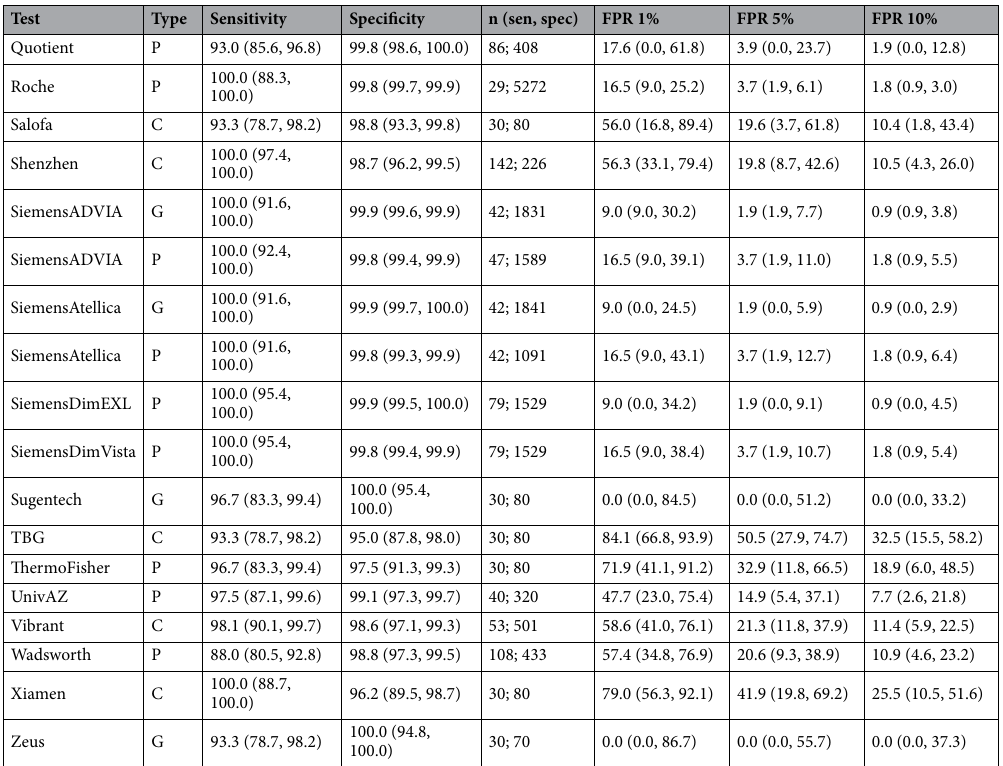
Table 1. Statistics for FDA authorized serology tests with EUA. All numbers are percentages. Interval estimates for sensitivity and specificity are 95% confidence intervals reported by the FDA 33 . Interval estimates for the false positive rates are minimum and maximum values of all possible false positive rates calculated at the specified prevalence level for the corresponding test based on all possible estimates of sensitivity and ∗ specificity within the 95% confidence intervals. n refers to the number of samples used to calculate the pretest probabilities. The number on the left refers to the number of samples with infected with SARS-COV-2 that were tested to estimate sensitivity. The number on the right refers to the number of control samples used to estimate specificity. Test types are shortened as followed. “G” denotes IgG, “M” denotes IgM, “C” denotes combined IgG/IgM, and “P” denotes